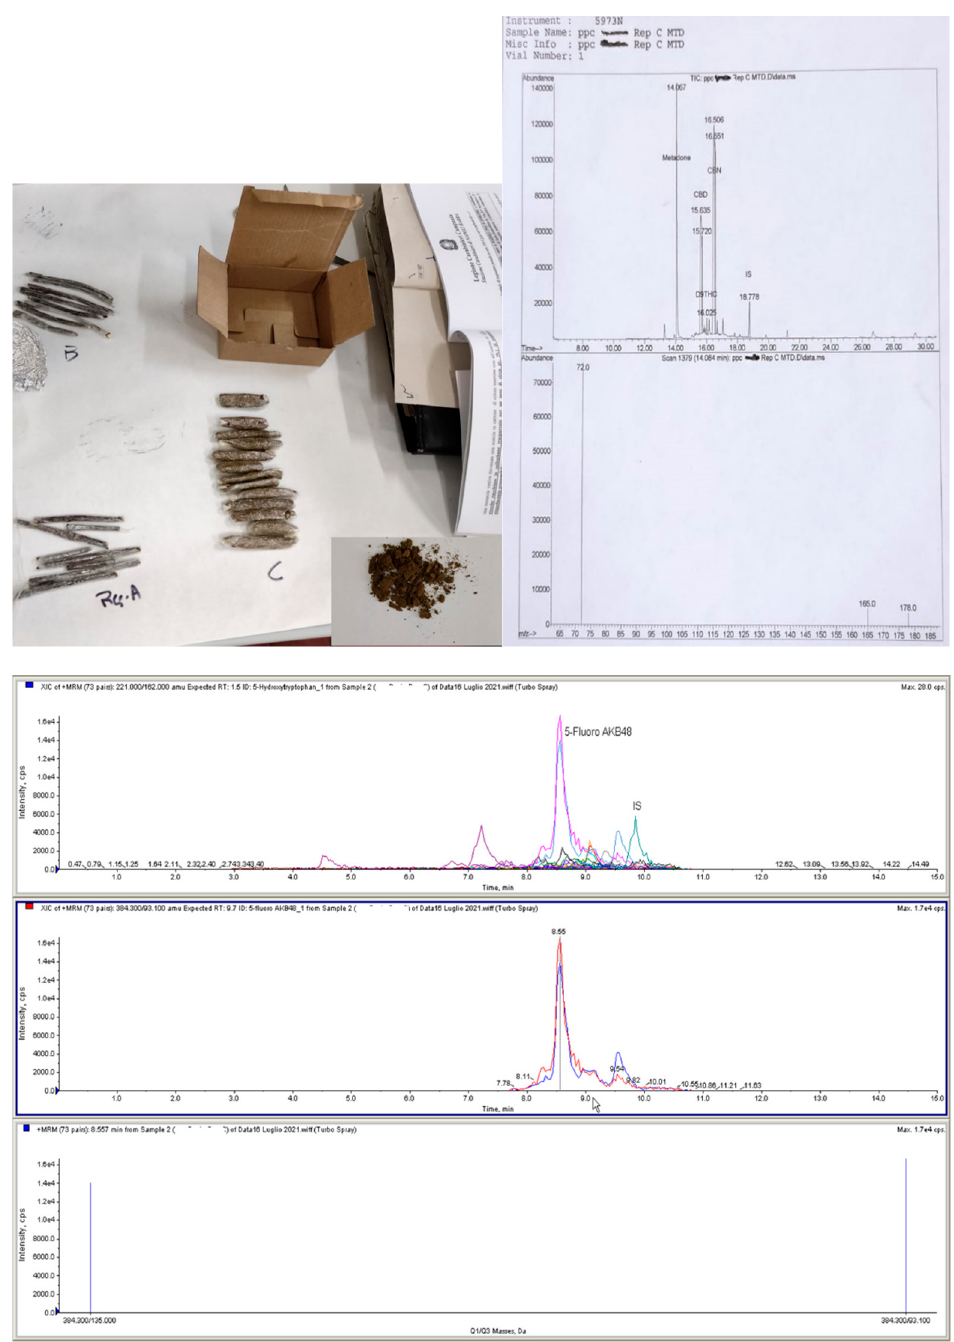
Figure 3. Case #2: the long thin bars (Rep A and B) resulted in Hashish with 11.85% and 10.75% Δ 9 THC concentrations, respectively. In the small fat cigars (Rep. C) containing a brown vegetal resinous substance showed the presence of Δ 9 THC = 0.27% (level of active principle less than 0.5%) and synthetic cannabinoid 5F-APINACA (4.1%) (graphic in LC-MS/MS) associated with methadone (1.0%) (graphic in GC/MS).